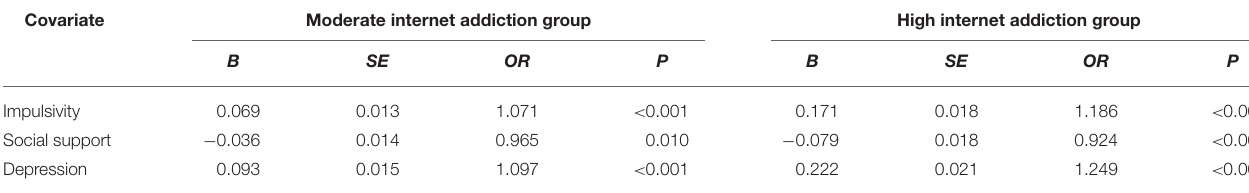
TABLE 4 | Predictors of group membership with low internet addiction group as the reference group.